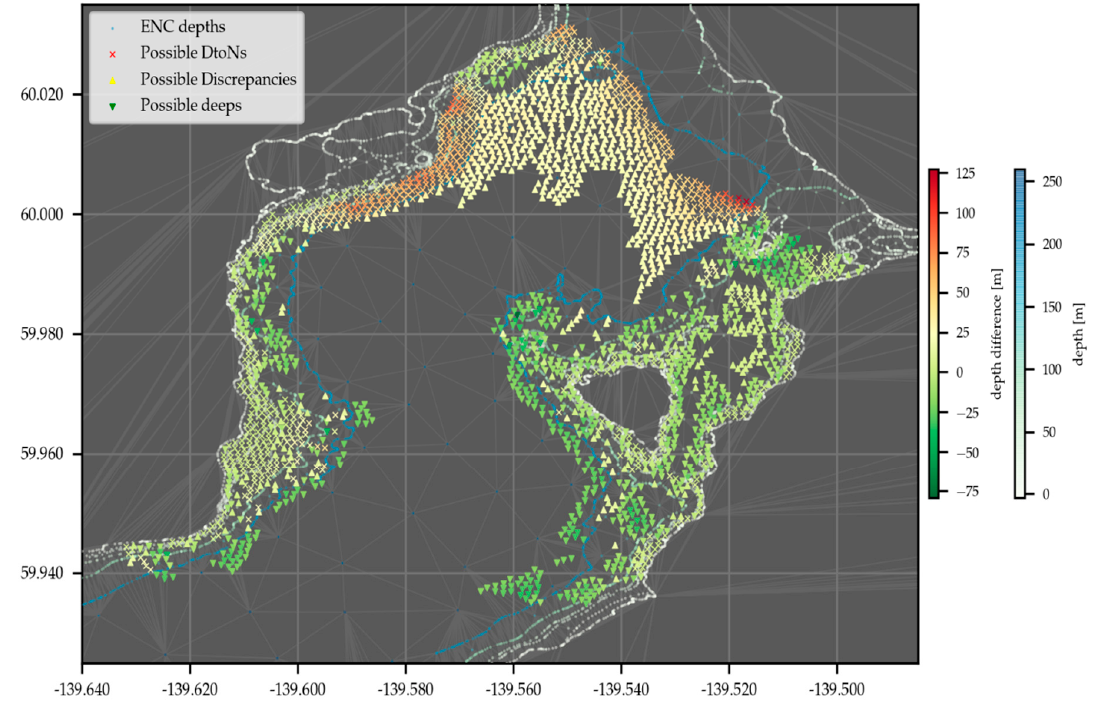
Figure 13. Algorithm results using the H13701 survey soundings compared to the US4AK3XM ENC. Axes in geographical WGS84 coordinates.